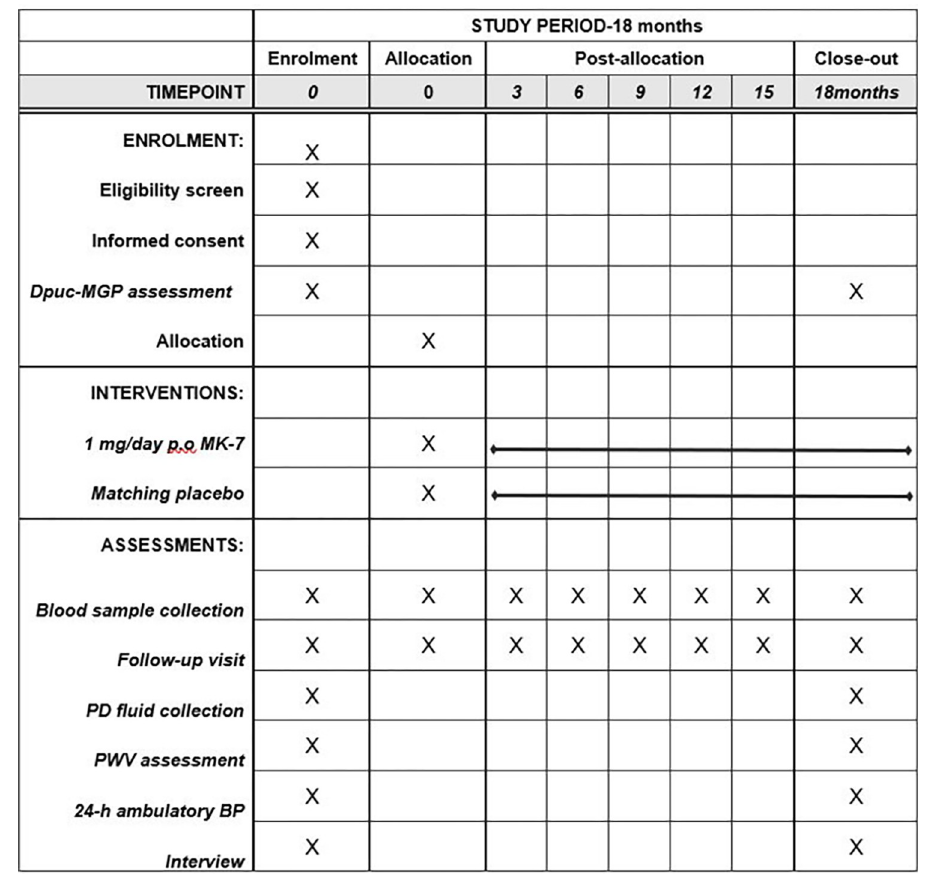
Fig 1. SPIRIT schedule of enrolment, interventions, and assessments of the VIKIPEDIA study.